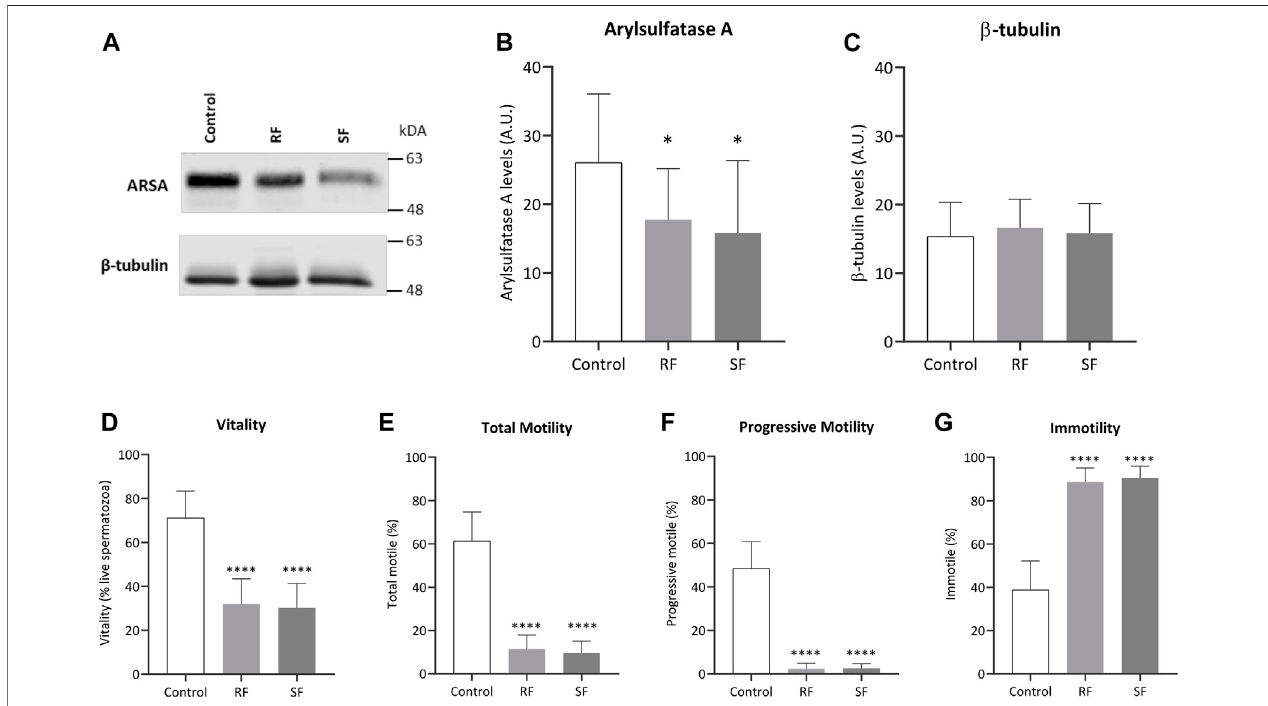
FIGURE 3 | Impact of cryopreservation on ARSA levels and sperm parameters. (A) Representative image of ARSA (62 kDa) and β -tubulin (50 kDa) levels in ejaculated human spermatozoa, from normozoospermic men ( n (cid:1) 15), before and after rapid and slow freezing. Whole-cell lysates were separated by SDS-PAGE ( B,C ) Quanti fi cation of ARSA and β -tubulin levels, respectively ( n (cid:1) 15). For each condition, the band intensity was normalized to Ponceau staining. (D) Sperm viability was assessed through the eosin-nigrosine staining. The impact of the freezing method was also observed in sperm (E) total motility, (F) progressive motility, and (G) immotility. In all graphs, bars represent the mean values, and the error bars correspond to the standard deviation. Statistically signi fi cant fi ndings compared with control are indicated with a * p < 0.05 or **** p < 0.0001. RF, rapid freezing; SF, slow freezing.